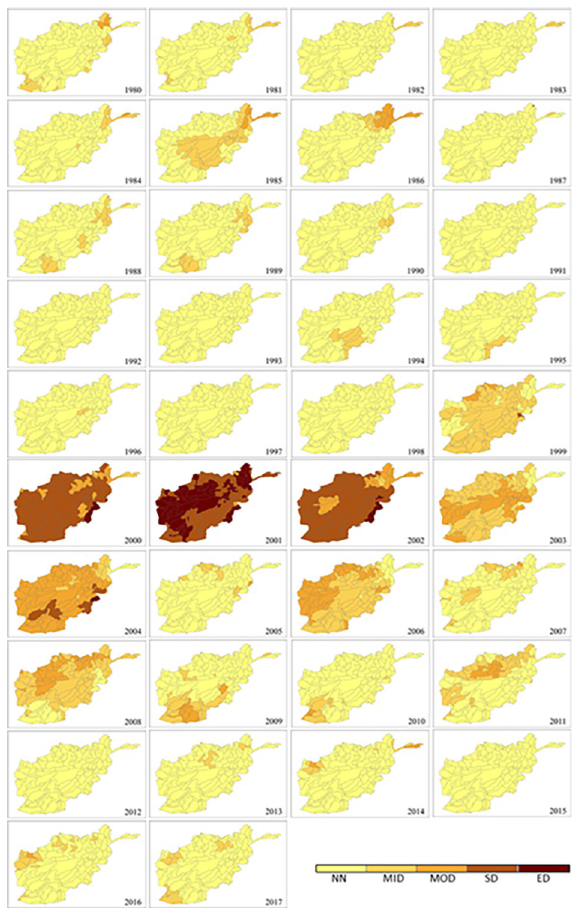
Fig 5. Spatial distribution of the mean annual drought index (SPEI-12) at sub-catchment scale in Afghanistan for each year between 1980 and 2017.